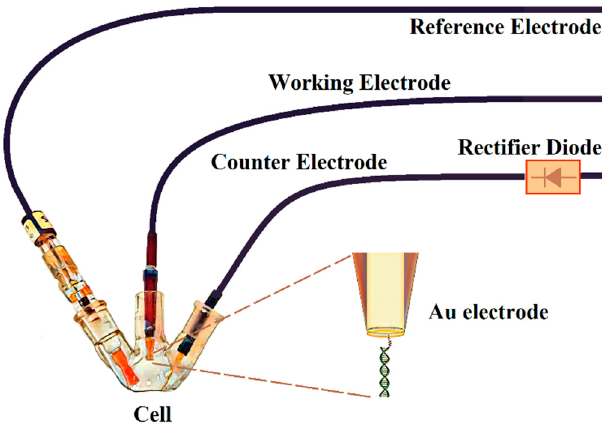
Figure 1. Schematic drawing of the electrochemical cell.